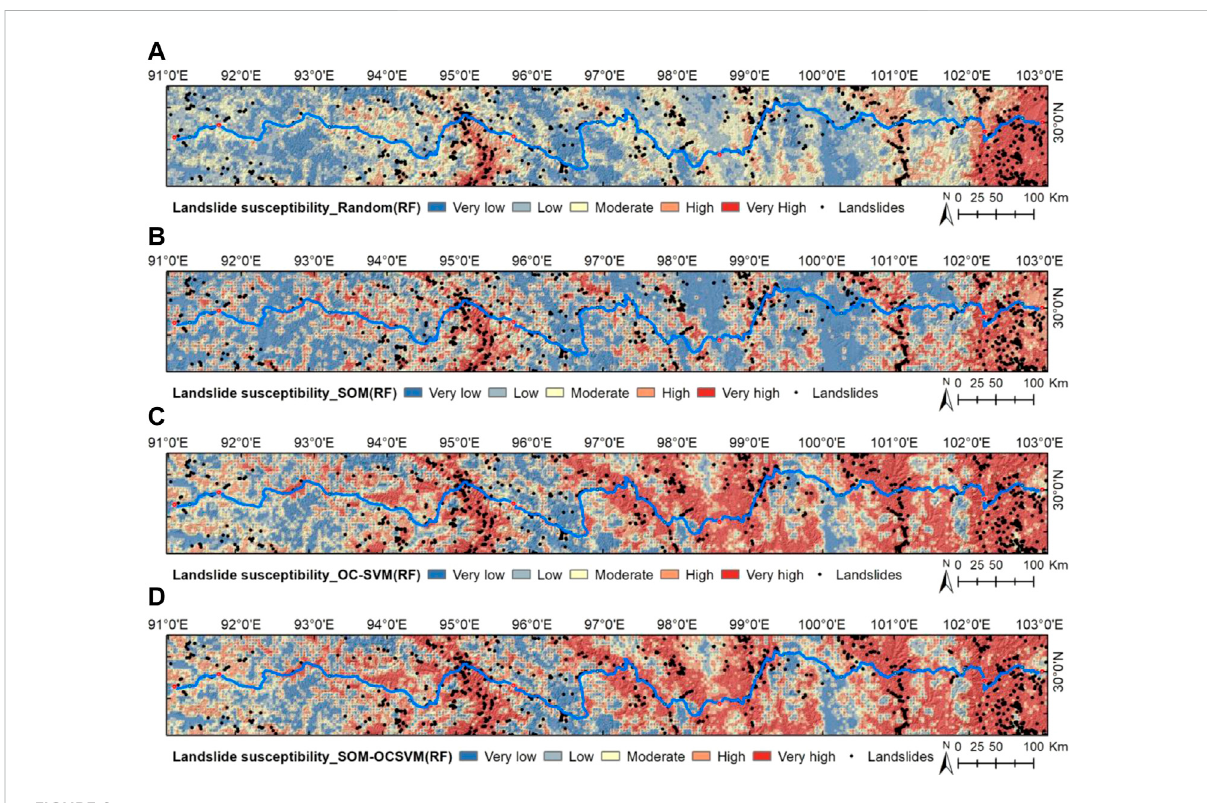
FIGURE 9 Landslide susceptibility map based on the RF with different negative data: (A) random, (B) SOM, (C) OC-SVM, and (D)